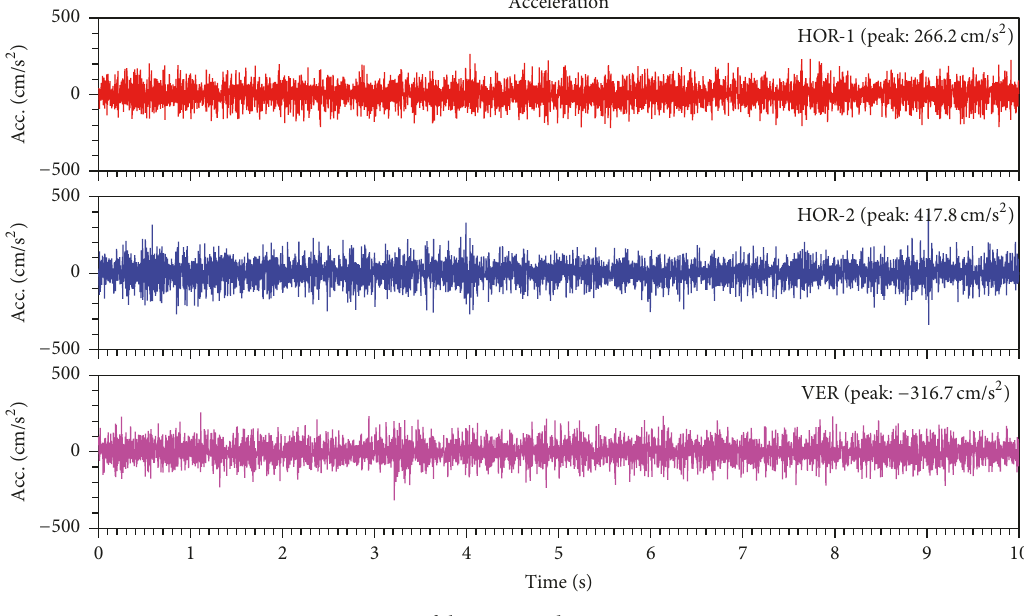
Figure 7: A part of the measured microtremor in span 1.